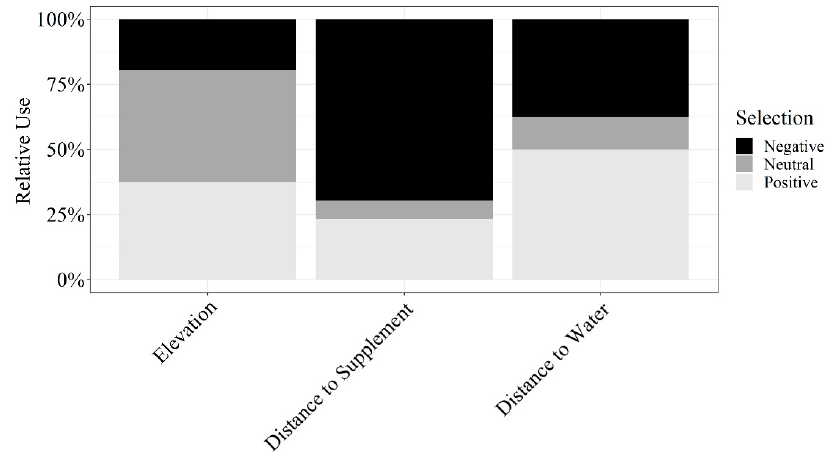
Figure 7. Influence of elevation, distance to supplement, and distance to water on relative use by cattle grazing dormant northern mixed-grass prairie in 2018/2019 and 2019/2020 at the Northern Agriculture Research Center’s Thackeray Ranch, Havre, MT, USA.